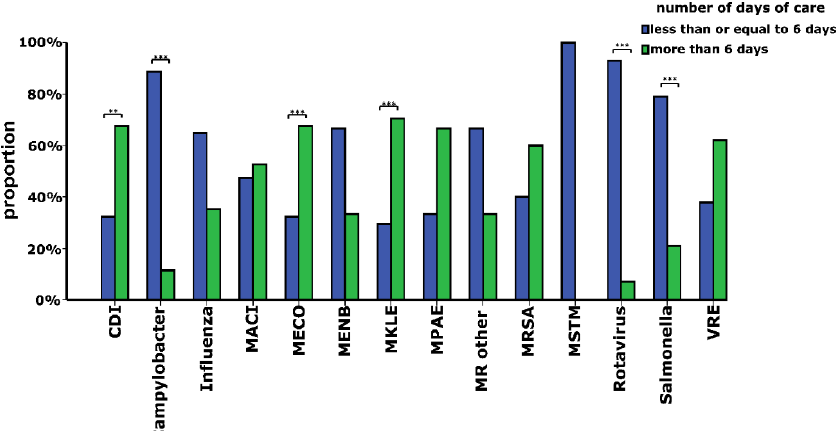
Figure 3. Number of days of care of patients with community-acquired infections detected at the University of Debrecen Clinical Centre Nagyerdei Campus in 2020 by the type of infectious disease. Median, interquartile ranges and 1.5 times of interquartile ranges as whiskers are shown. Asterisks indicate outlier values. Abbreviations: CDI: Clostridioides difficile , MRSA: Methicillin-resistant Staphylococcus aureus , MECO: Multidrug-resistant Escherichia coli , MKLE: Multidrug-resistant Klebsiella spp., MPAE: Multidrug-resistant Pseudomonas aeruginosa , MACI: Multidrug-resistant Acinetobacter baumannii , MENB: Multidrug-resistant Enterobacter spp., MSTM: Multidrug-resistant Stenotrophomonas maltophilia , MR OTHER: Other Multidrug-resistant organisms ( Proteus mirabilis, Citrobacter freundii, Morganella morganii ), VRE: Vancomycin-resistant Enterococcus spp.